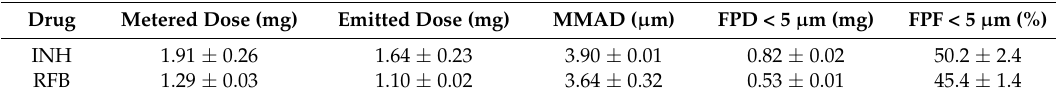
Table 2. Aerodynamic parameters of fucoidan microparticles loaded with isoniazid (INH) and rifabutin (RFB) in the combined formulation. Loaded amount of powder in the capsule was 30 mg, corresponding to 2.6 mg of INH and 1.4 mg of RFB, according to the drug content of formulation ( n = 3, mean ± SD). Drug Metered Dose (mg) Emitted Dose